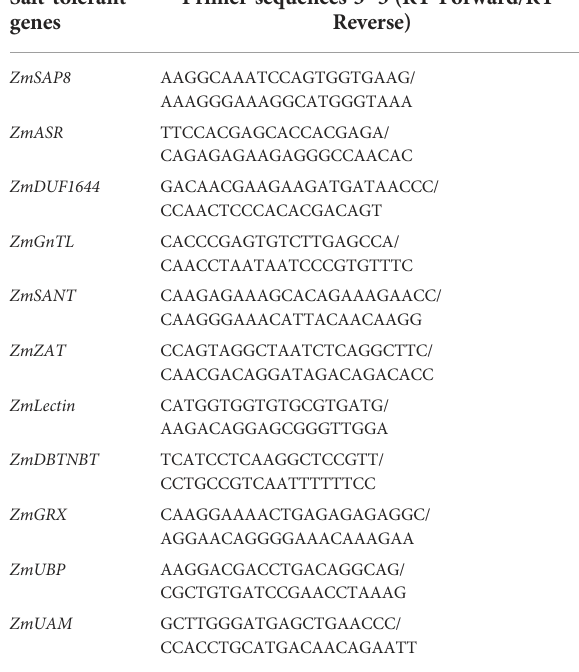
TABLE 1 qPCR primers for candidate salt-tolerance genes. Salt-tolerant